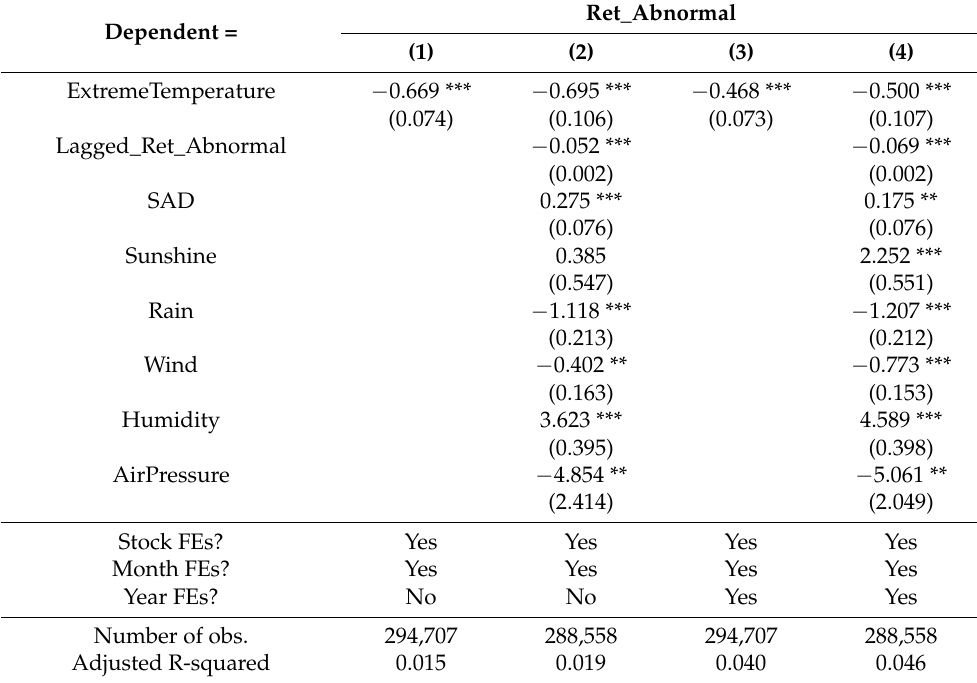
Table 3. The impact of extreme temperature on firm-specific stock